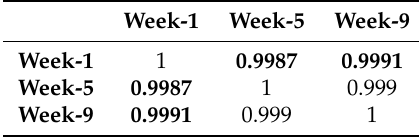
Table 5. Pairwise cosine-similarity among selected three weeks observation